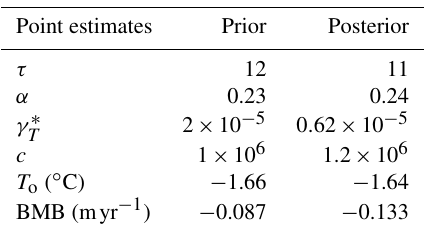
Table B1. Comparison between the forcing temperature and inte- grated basal mass balance across the total ice shelf for prior and posterior parameter values. In the prior case we use the parameter values for γ ∗ and c proposed in Reese et al. (2018a) and use mean T point estimates from our prior distributions for τ and α . Our poste- rior case uses point estimates for all parameters from our posterior